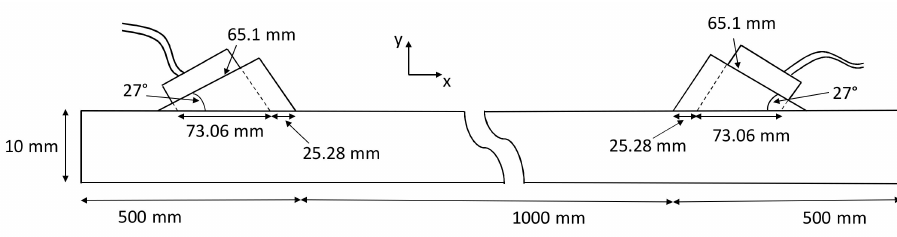
Figure 14. Experiment setup of 10 mm steel plate, selective higher mode excitation with angled probe with phased array.